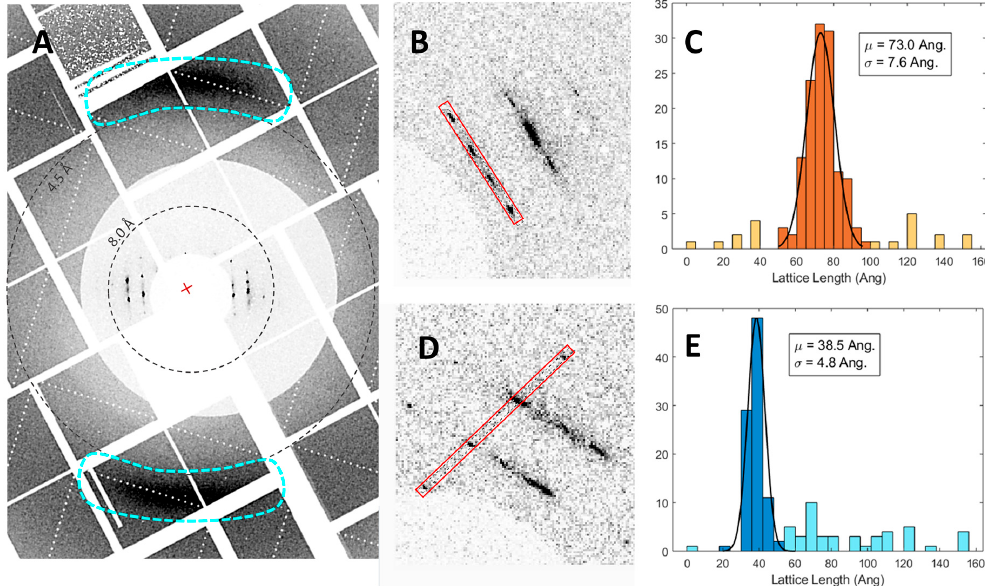
Figure 4. An example of hits collected at MFX for S816-4 ApoA1 at MFX showing ( A ) anisotropic di ff raction and di ff use features at 4.2 Å, and averaging of signal intensities along ( B ) layer lines and ( D ) an orthogonal crystallographic axis. The equivalent histograms of the reflection spacing measured from ( B ) and ( D ) are shown in ( C ) and ( E ),